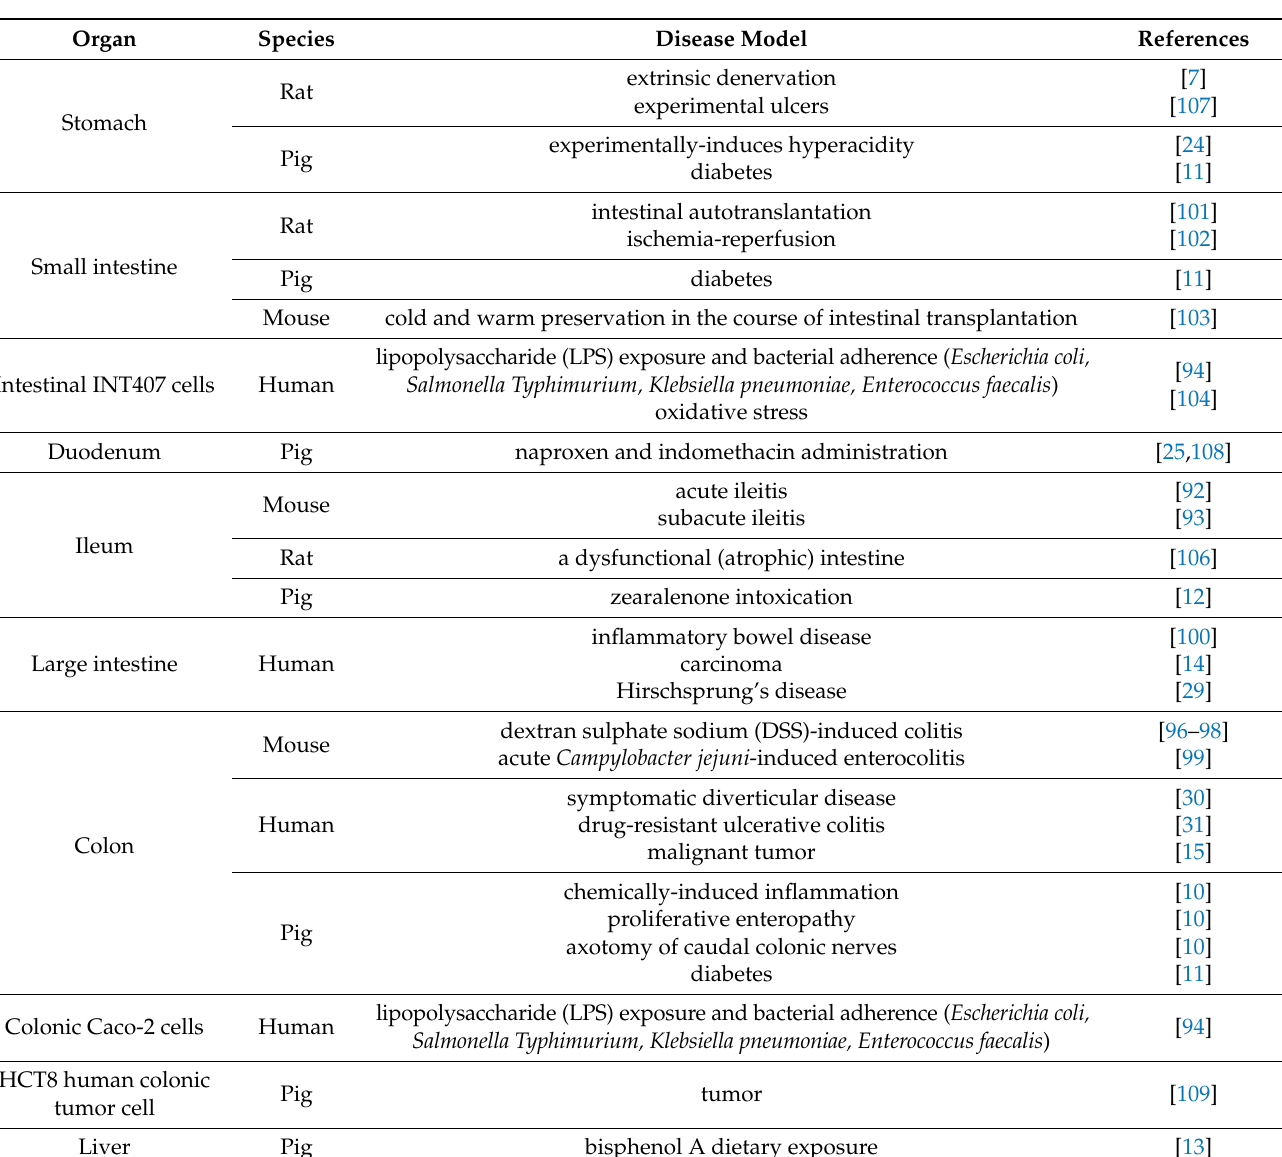
Table 2. The involvement of PACAP in the regulation of gastrointestinal